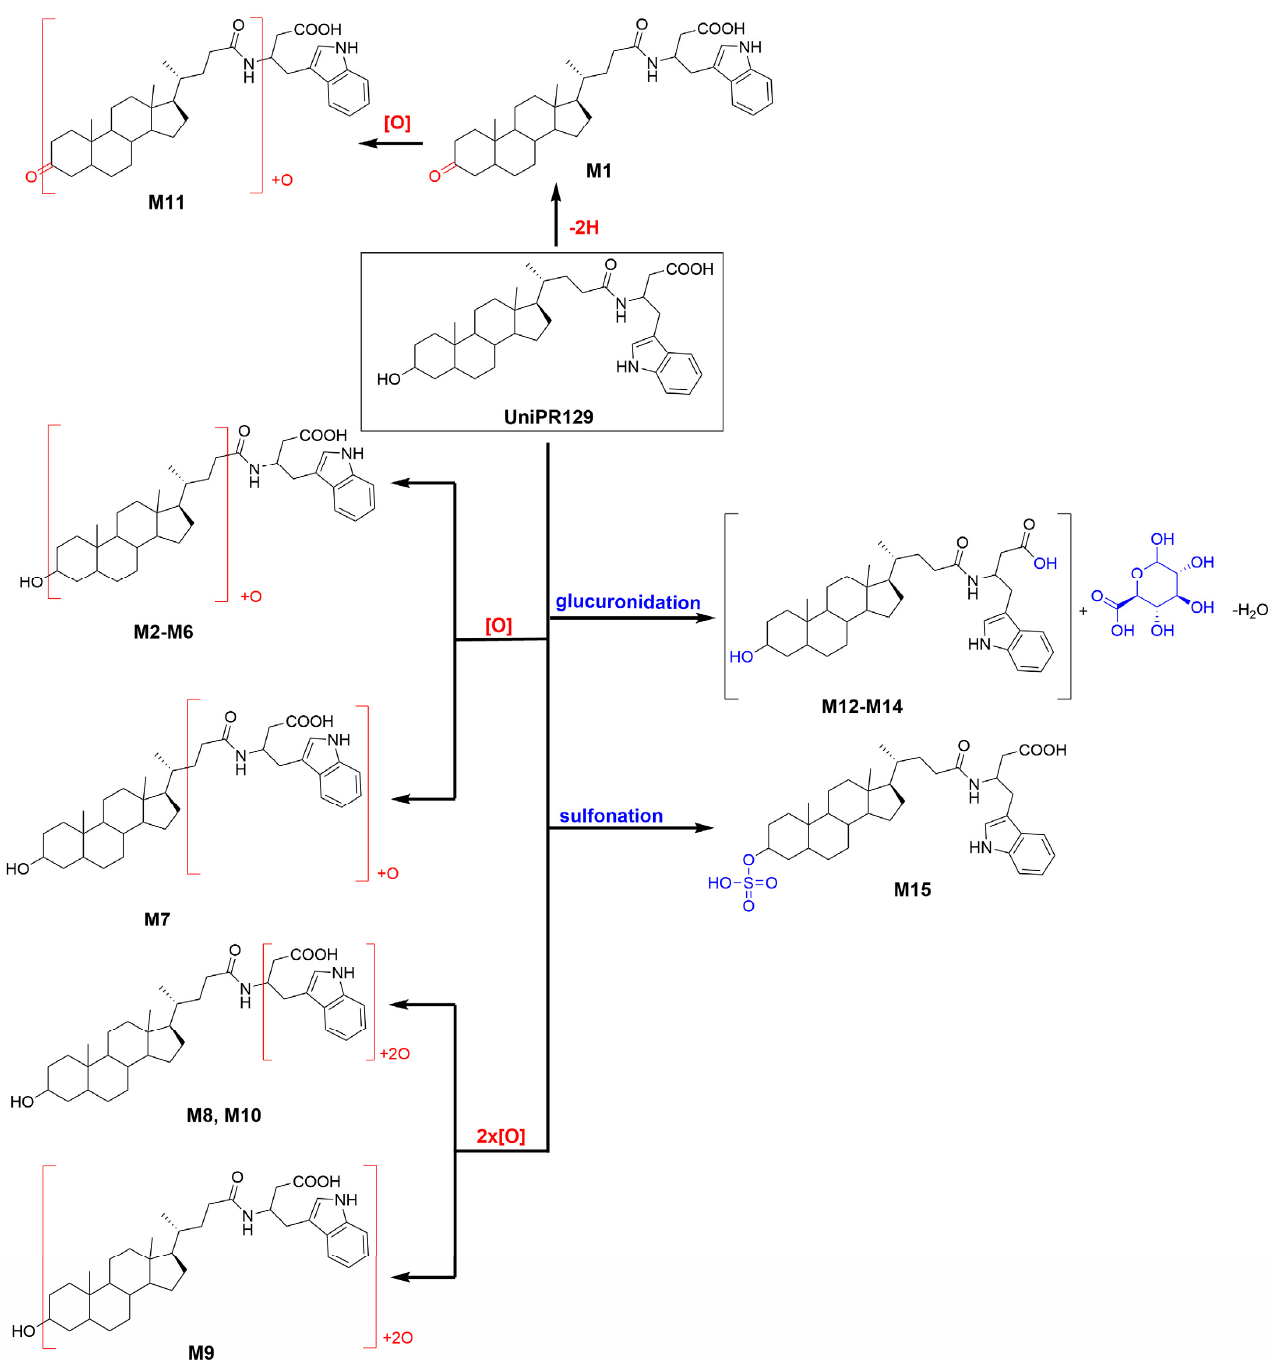
Figure 4. Metabolic tree of UniPR129 plausible phase I and II in vitro